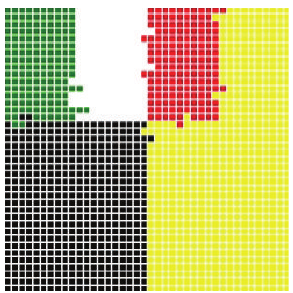
Figure 5: Optimal project